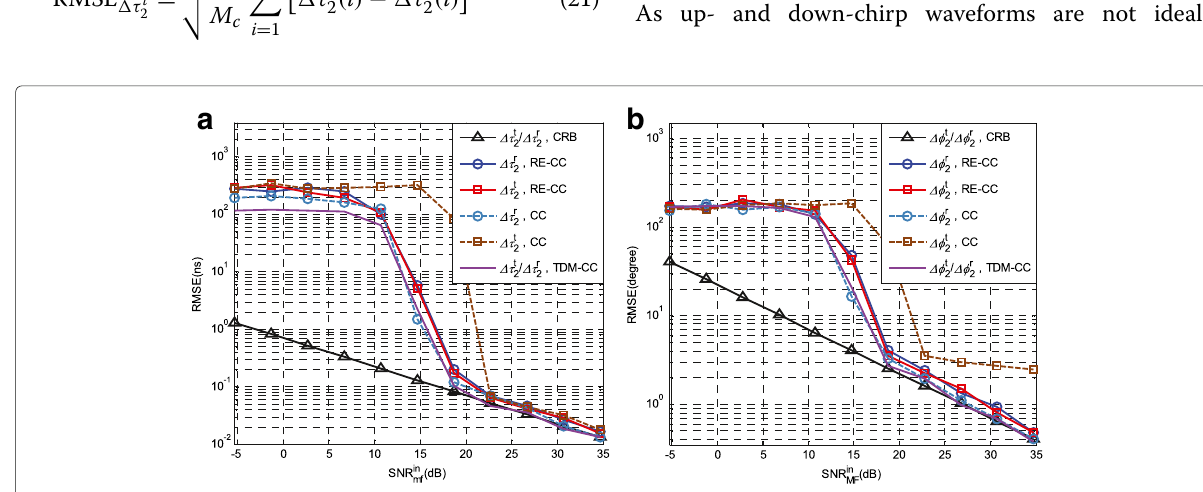
Fig. 5 RMSEs of estimated CPs versus SNR in